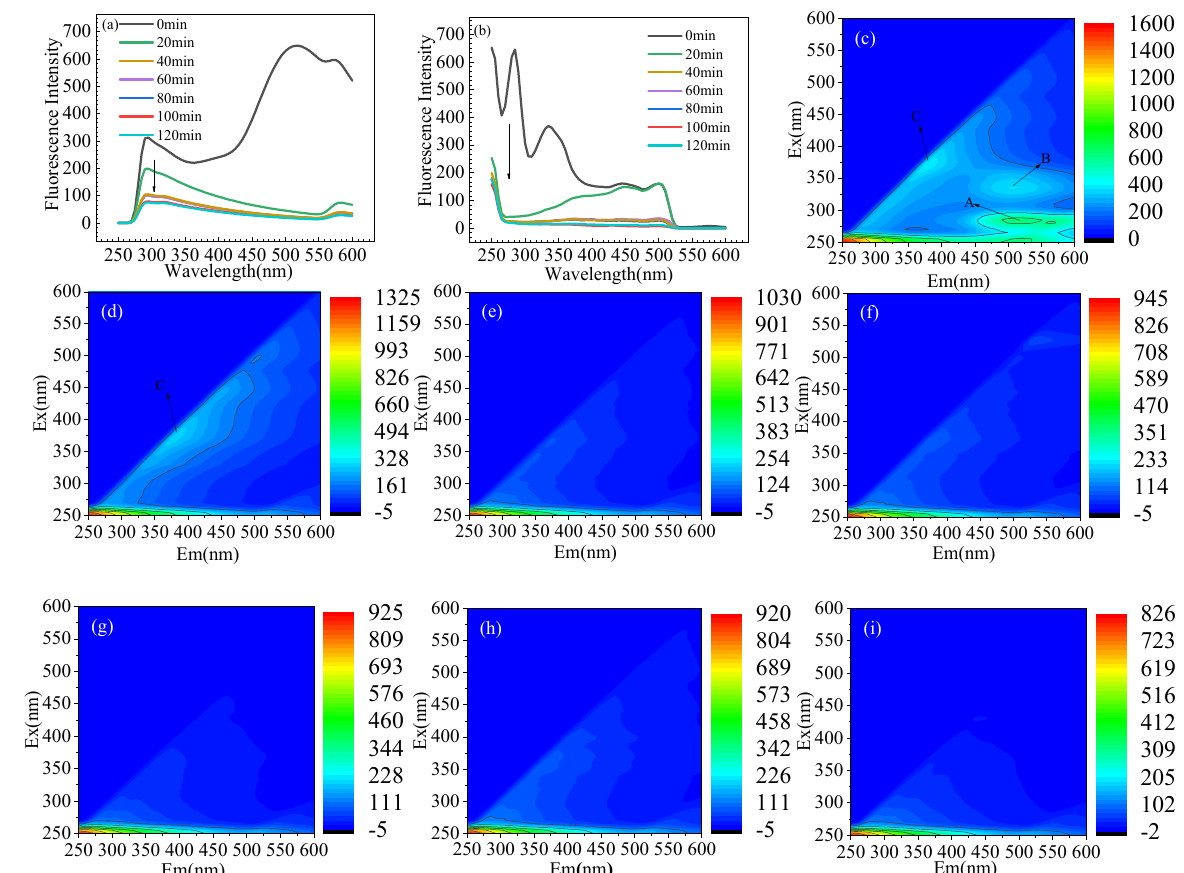
Figure 6. ( a ) Fluorescence spectra of LVX at emission wavelength of 510 nm. ( b ) Fluorescence spectra of LVX at 290 nm excitation wavelength. Three-dimensional EEMs of LVX solution after electrocatalysis degradation of ( c ) 0, ( d ) 20, ( e ) 40, ( f ) 60, ( g ) 80, ( h ) 100, and ( i ) 120 min by titanium suboxide anode.